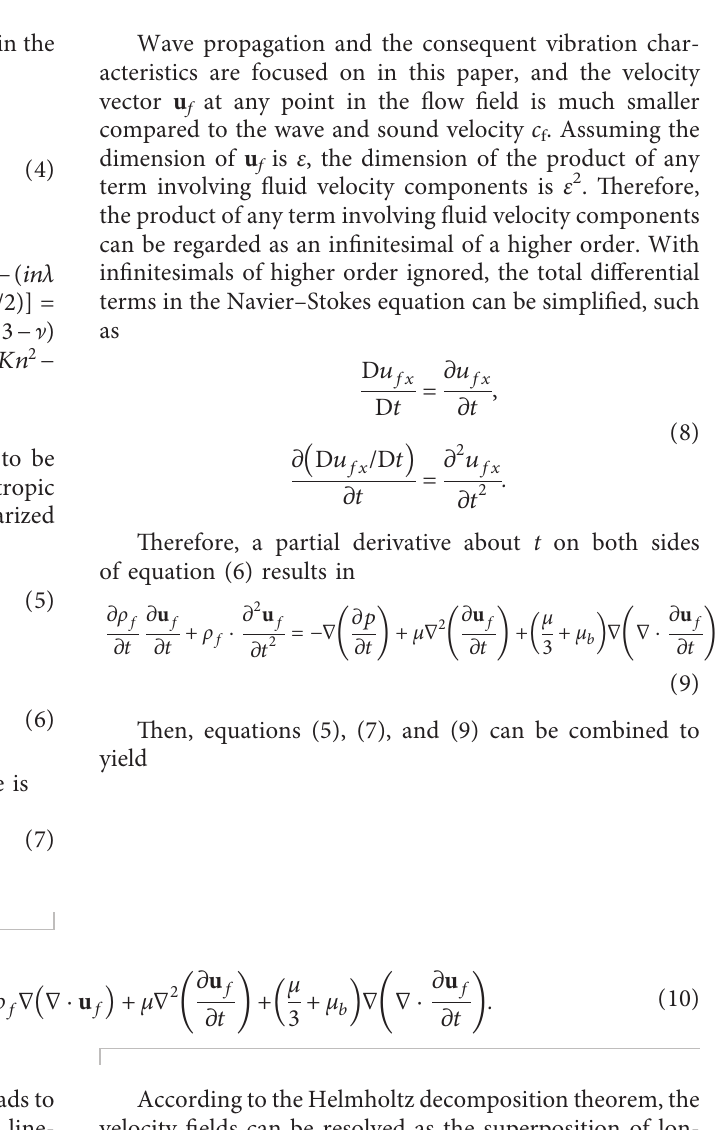
Figure 1: Coordinate system and circumferential mode